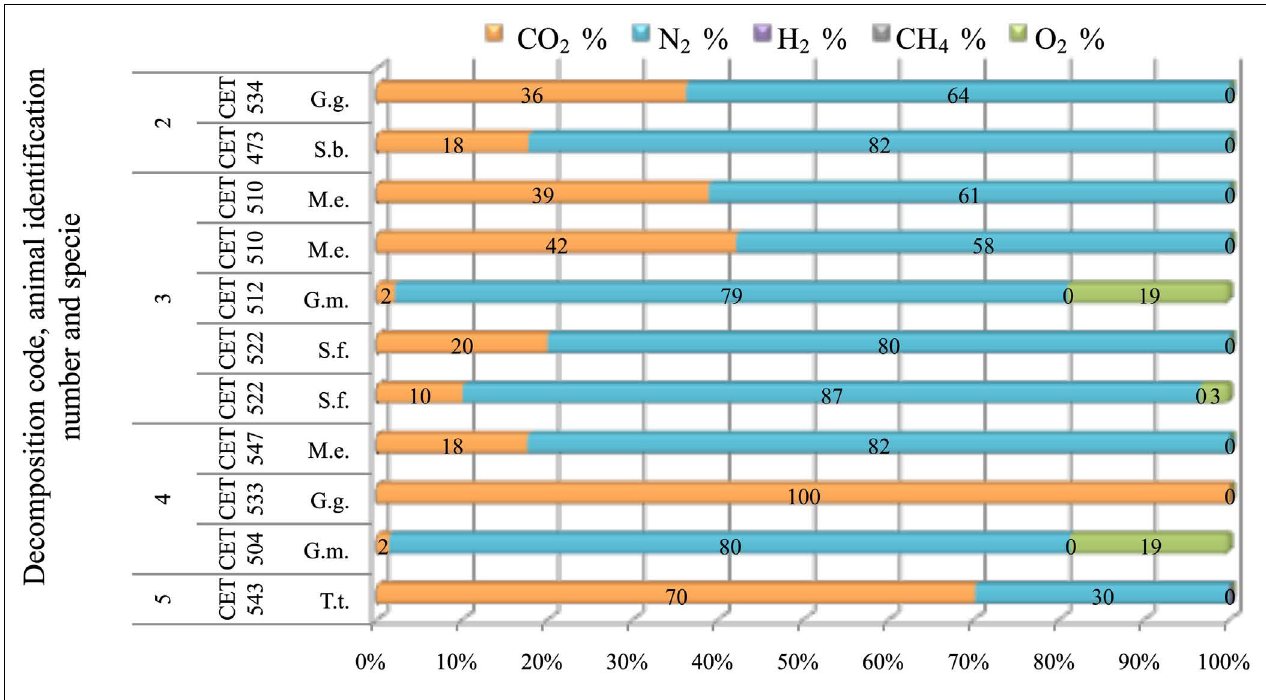
macrorhynchus ;T.t., Tursiops truncatus ) with different decomposition codes, illustrating the contribution of each gas to the total amount in percentage μ